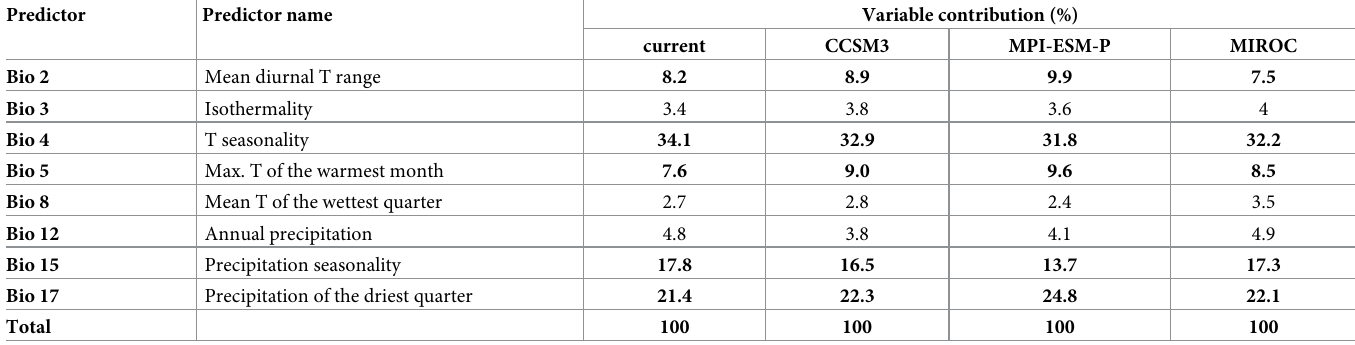
Table 1. Contribution of selected environmental predictor variables. Variable contributions exceeding 5% are displayed in bold; temperature abbreviated as T.